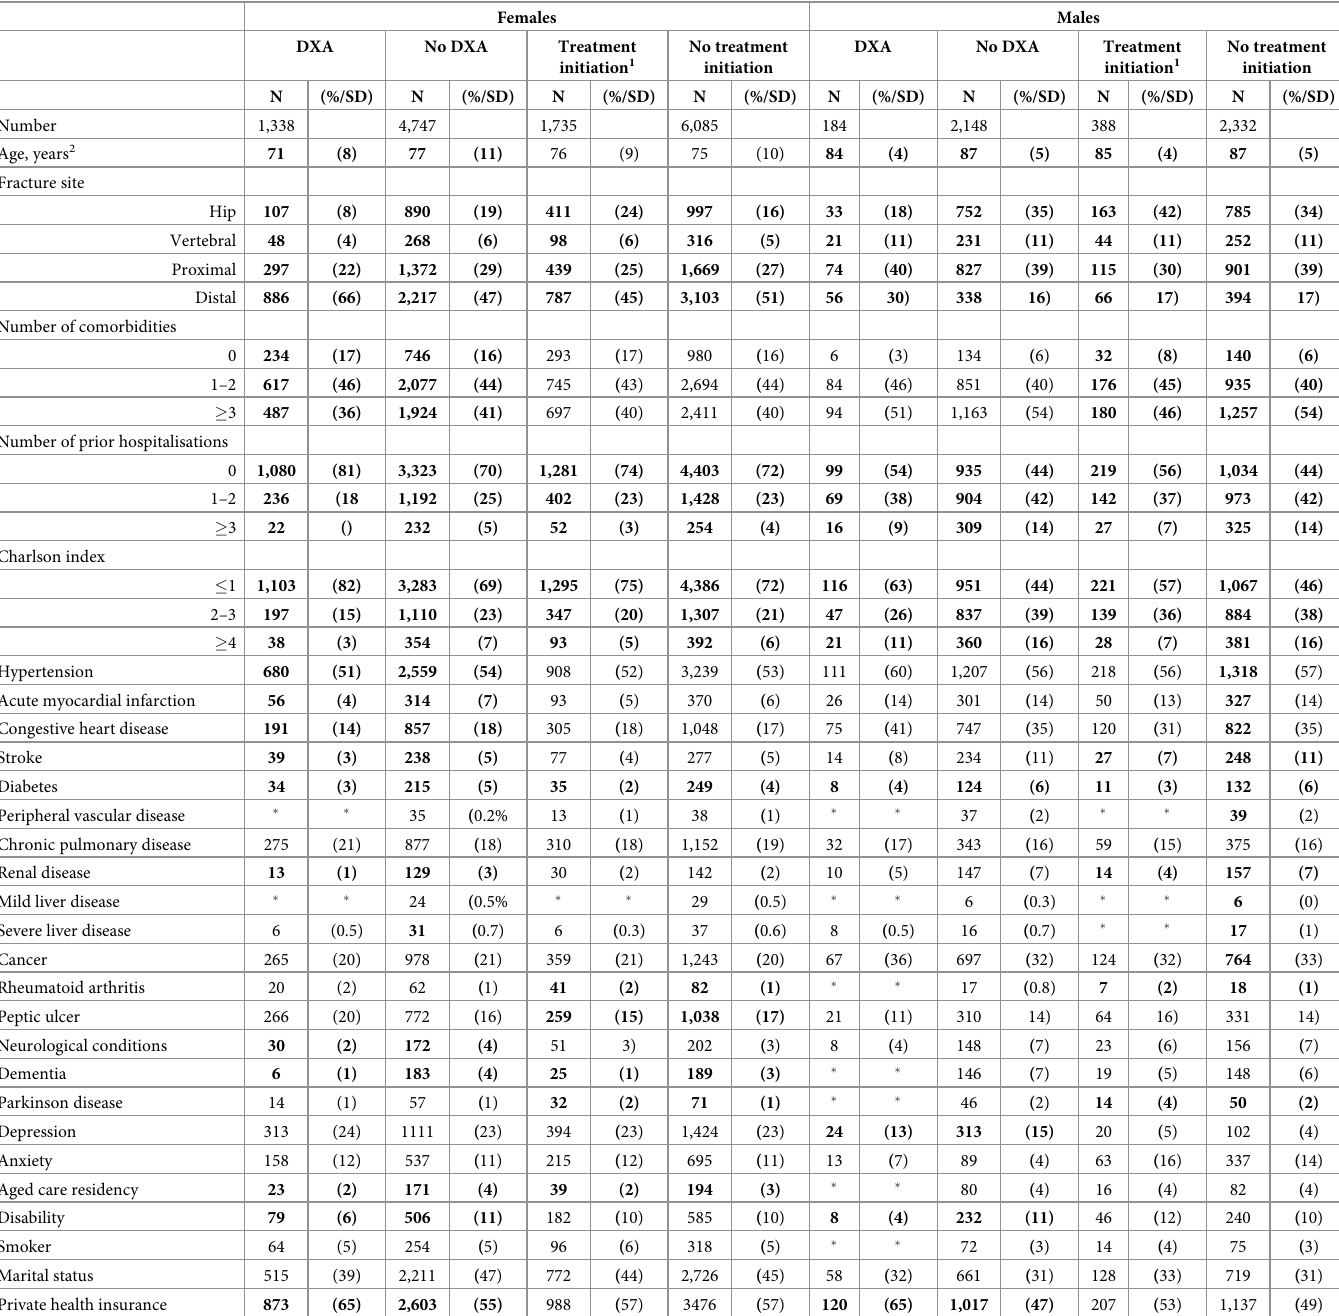
Table 1. Characteristics at the time of index fracture for females and males in the high-risk group according to DXA referral and treatment initiation.